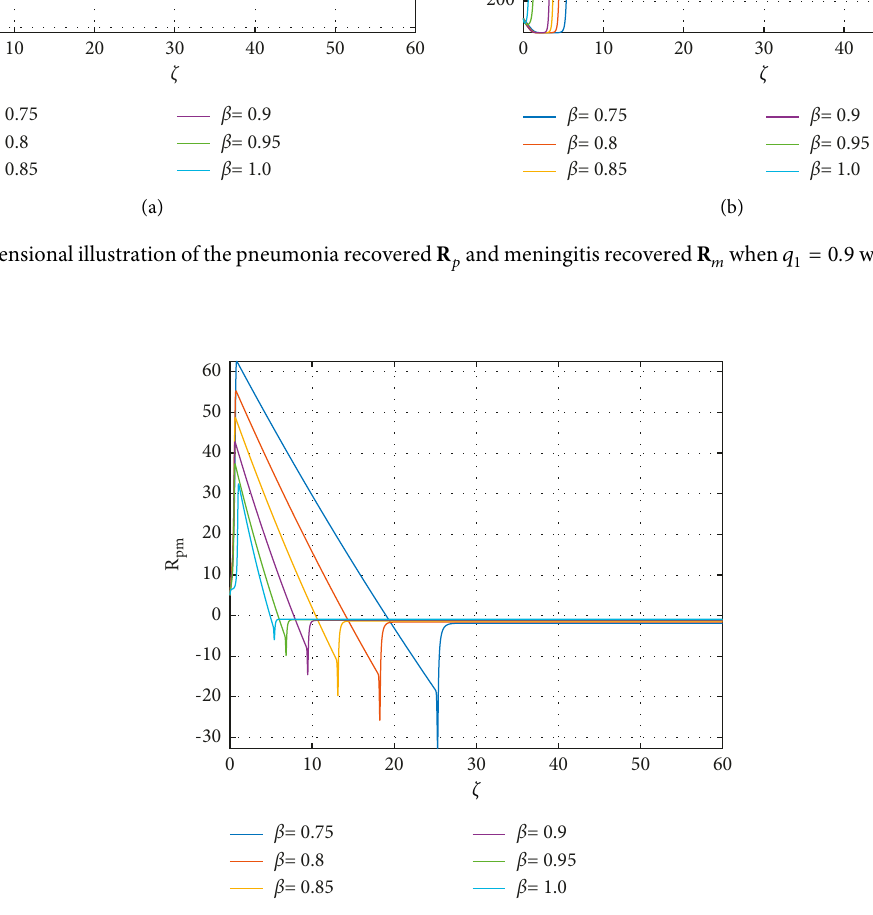
q � 0 . 9 with multiple fractional orders β ∈ [ 0 , 1 ] pm when 1